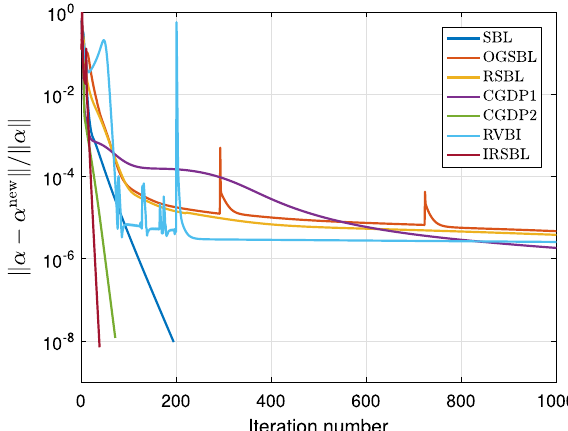
Fig. 8 Evolution of the relative rate of hyperparameters α